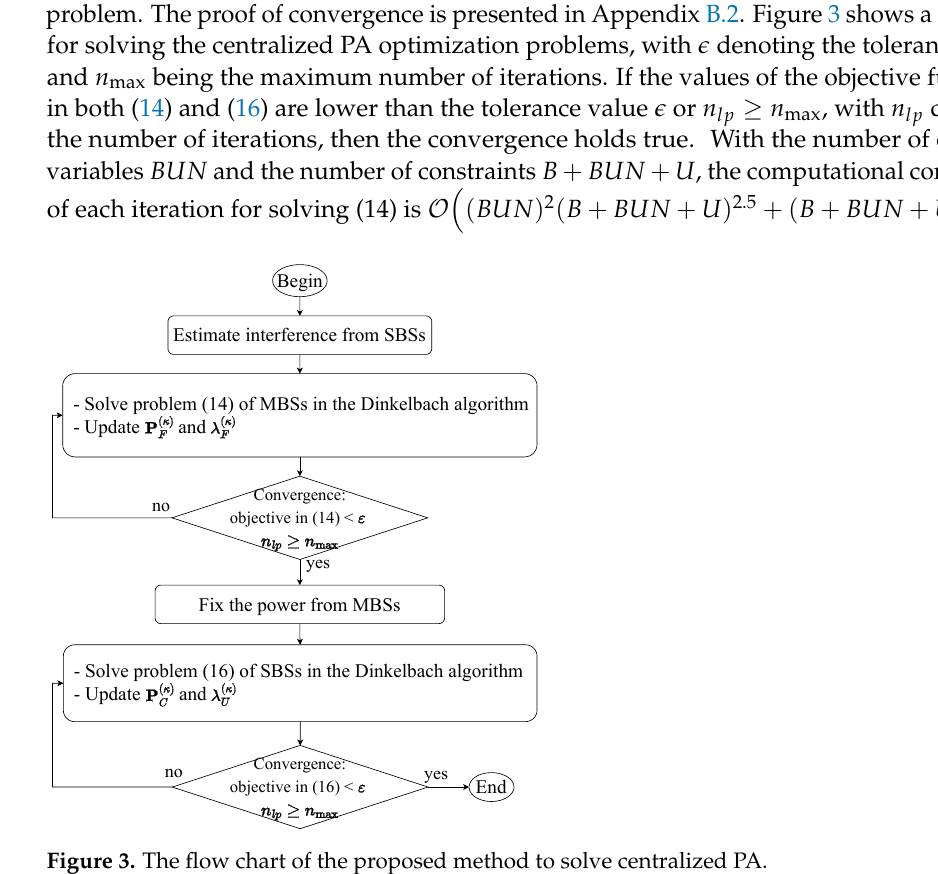
Figure 3. The flow chart of the proposed method to solve centralized